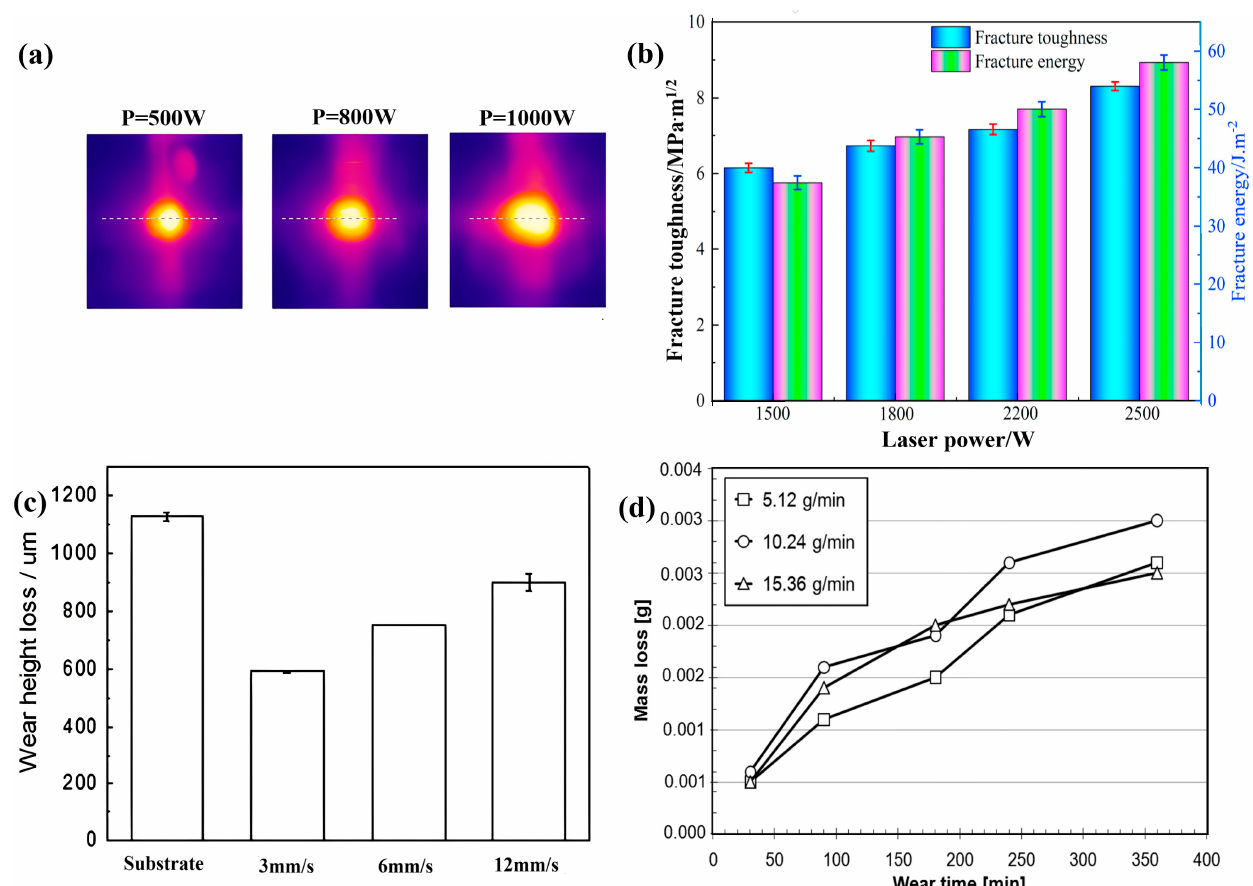
Figure 1. The influence of different laser power, scanning speed, and powder feeding rate on cladding results. ( a ) Effect of different laser powers on the melt pool. Reprinted from [59]. ( b ) Fracture toughness and fracture energy of coatings at different laser powers. Reprinted with permission from Ref. [60]. 2022, Elsevier. ( c ) Wear height losses of substrate and clad layers with different scanning speeds. Reprinted with permission from Ref. [61]. 2013, Taylor and Francis. ( d ) Effect of different powder feeding rates on the wear resistance of coatings. Reprinted with permission from Ref. [63]. 2016, Elsevier.